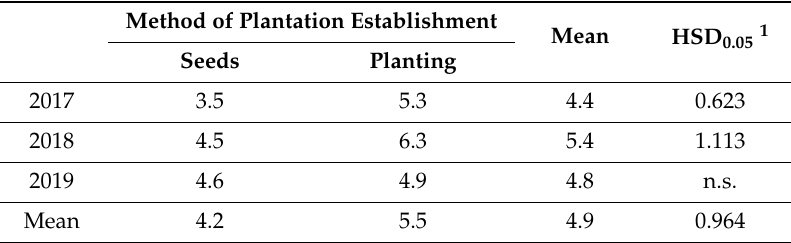
Table 5. The number of shoots per plant of Silphium, depending on methods of plantation establishment. Method of Plantation Establishment